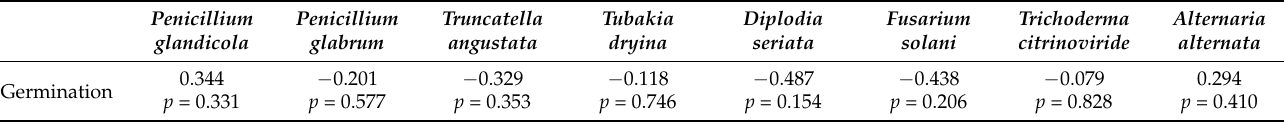
Figure 5. Correspondence analysis map showing association of the 10 most frequent fungal taxa with acorn storage categories (no storage, storage at − 1 °C, and storage at 3 °C). Table 2. Pearson correlation coefficients and related p values reveal no significant correlation between the number of obtained isolates of the eight most frequent fungal species and acorn germination in groups sown in a nursery trial. Penicillium